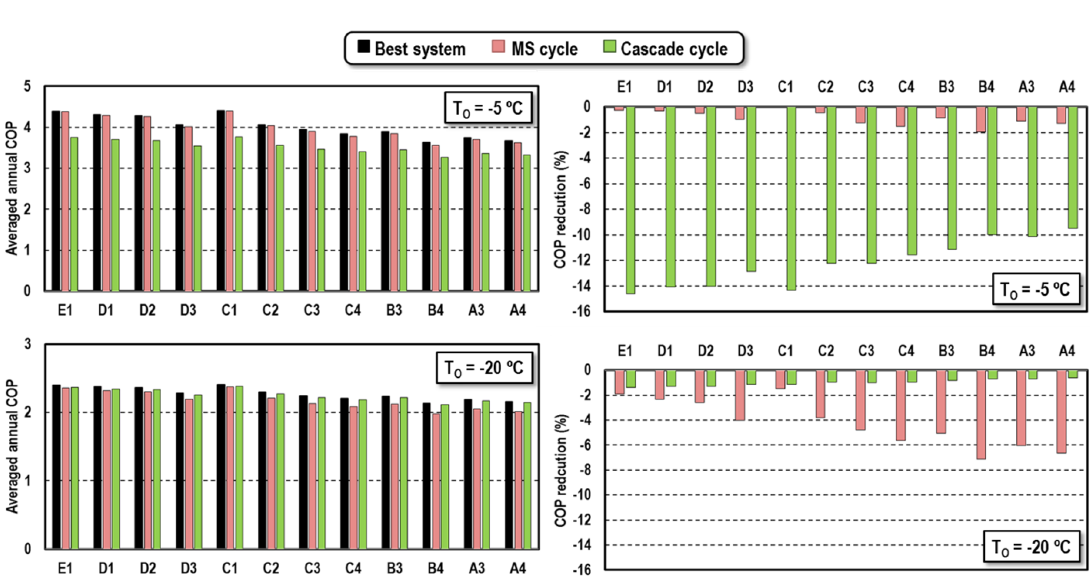
Figure 16. Percentage average annual COP deviations of MS and cascade cycles regards the best system.